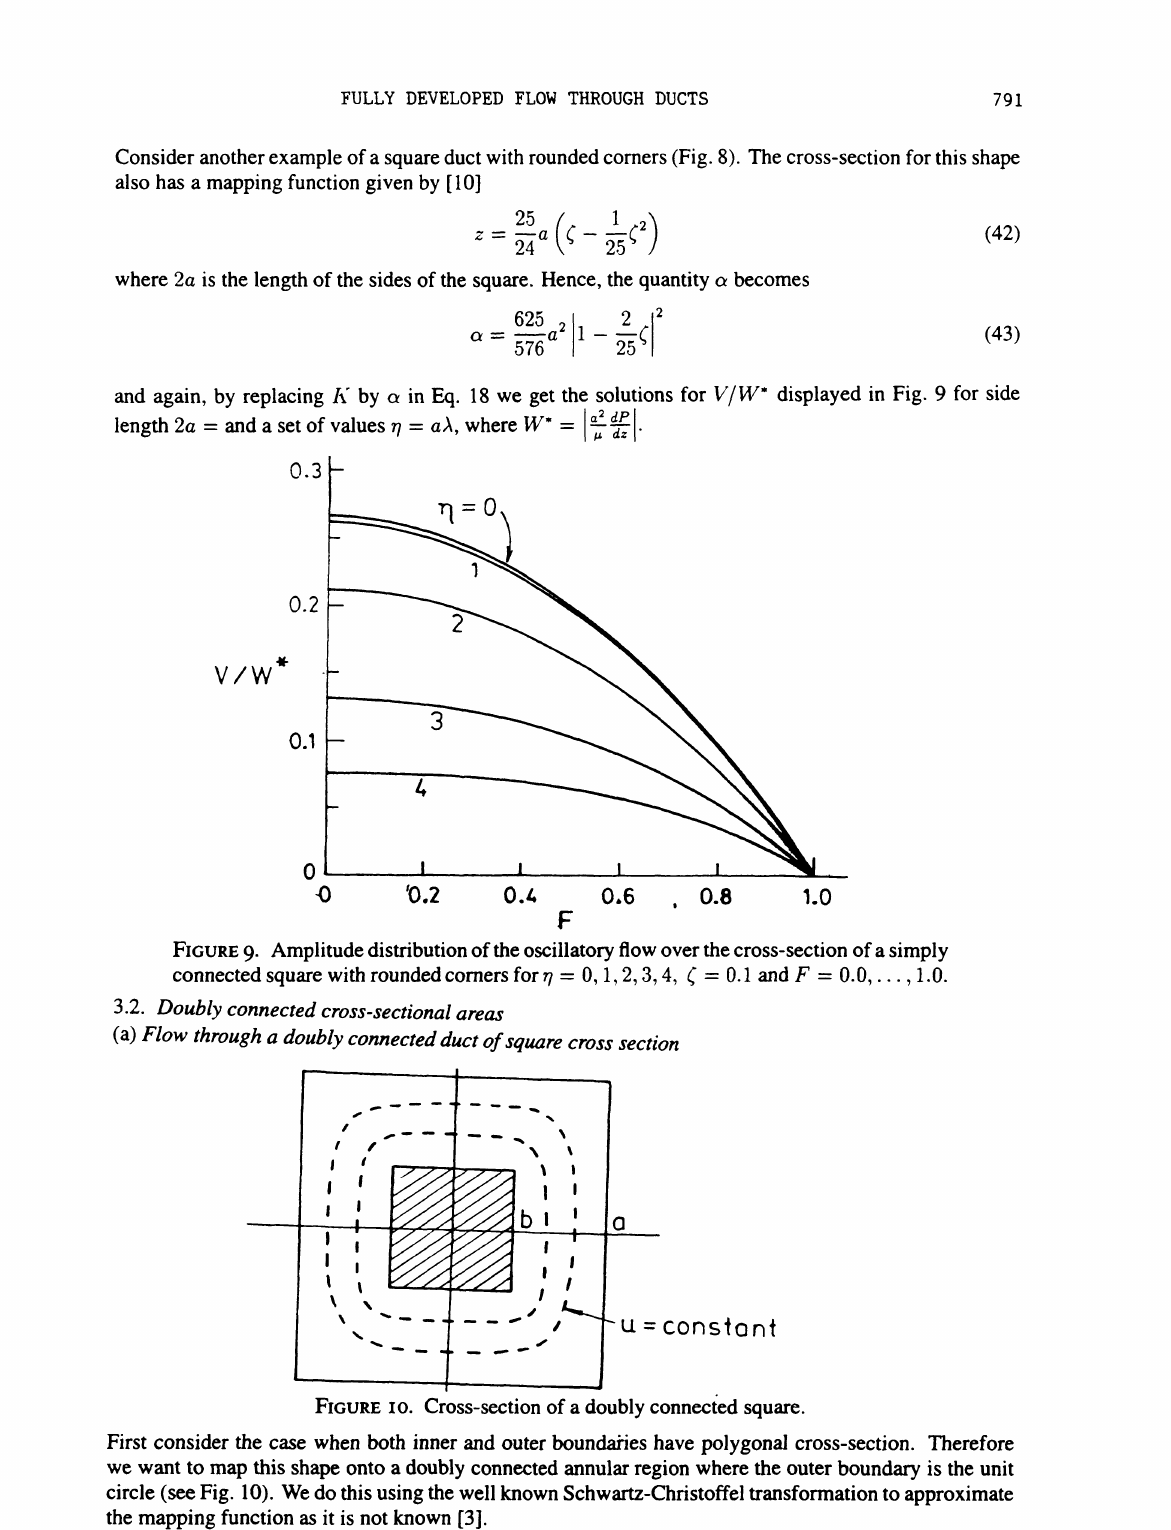
FIGURE IO. Cross-section of a doubly connected